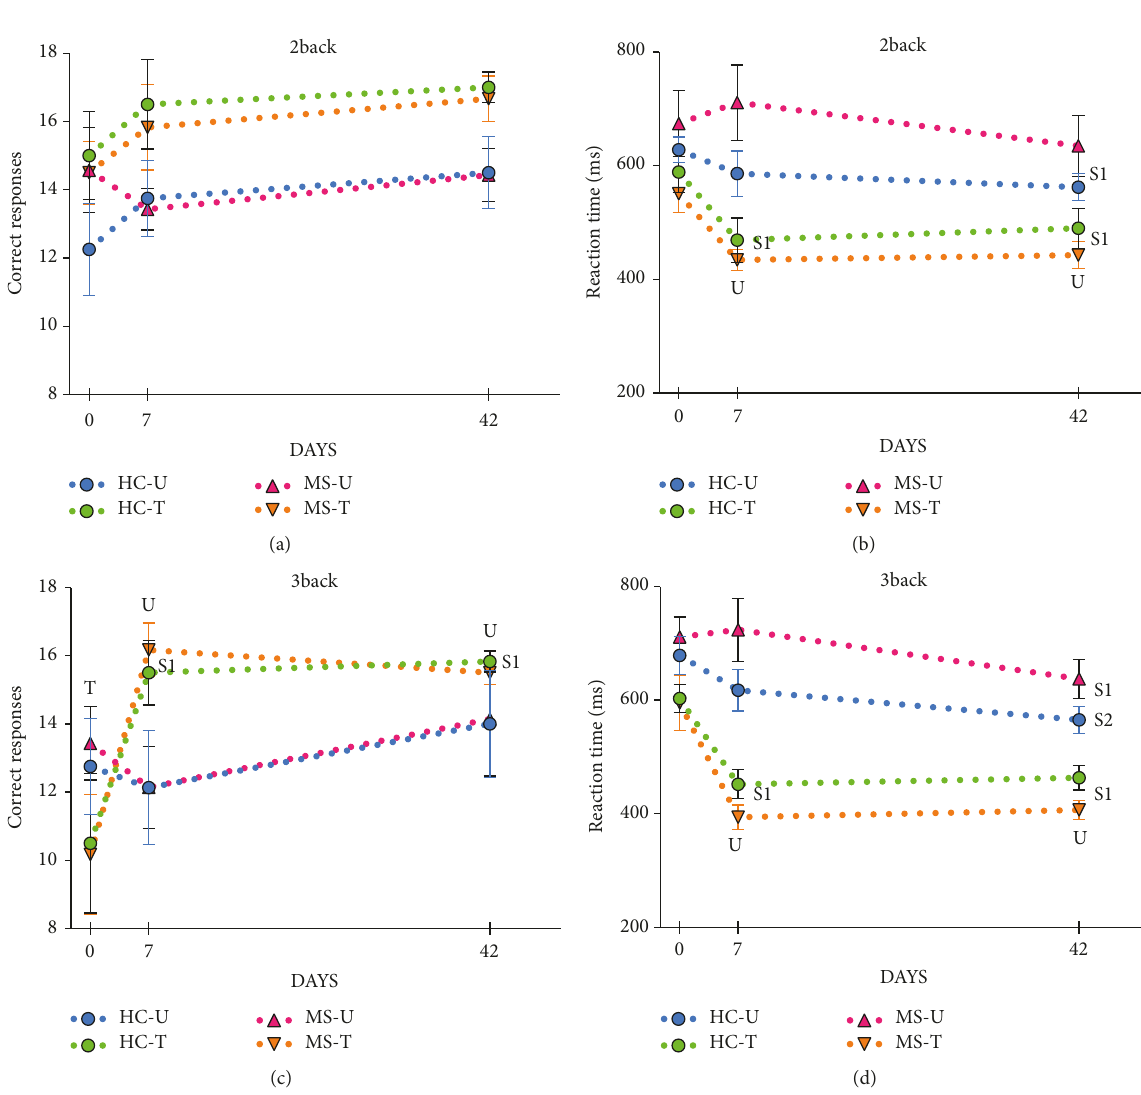
Figure 3: Behavioral results. Panels depict mean ± SEM of correct responses (CRs) and reaction times (RTs) for correct responses in the 2-back and 3-back tasks at each session. Trained groups exhibited shorter RTs but not an increased number of CRs (a) in the 2-back task at the posttraining (S2) and in the follow-up (S3) sessions than in the baseline (S1) session. Trained groups exhibited higher number of CRs (c) and shorter RTs (d) in the 3-back task at S2 and S3 than in S1 (U: different from untrained groups; T: different from trained groups; S1: different from baseline; S2: different from posttraining session; see Tables 3 and 4 for